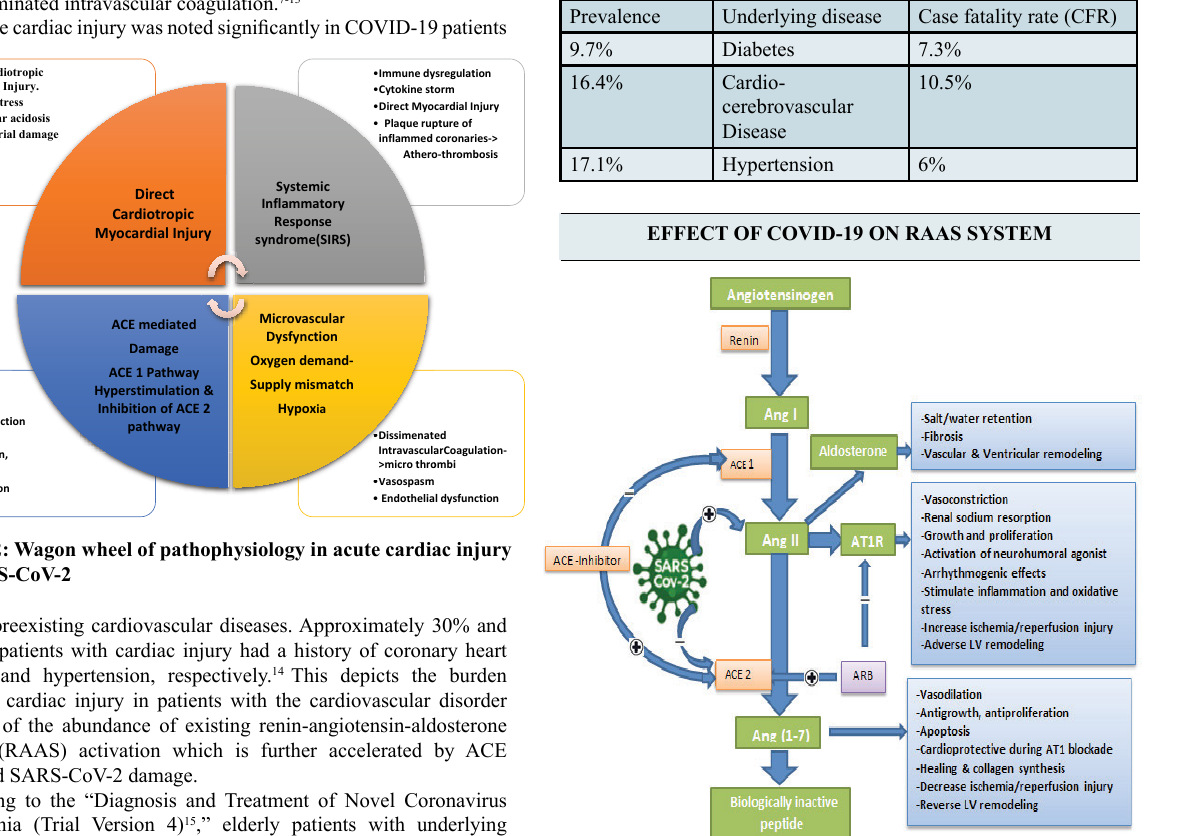
Angiotensin-Converting Enzyme and its receptor in COVID-19